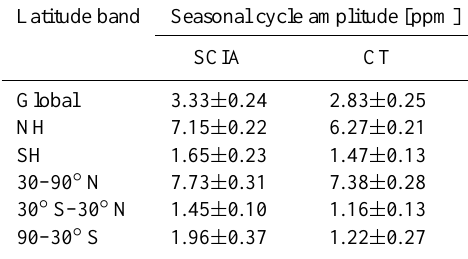
Table 1. Mean peak-to-peak amplitudes of SCIAMACHY and Car- bonTracker XCO 2 seasonal cycles for selected latitude